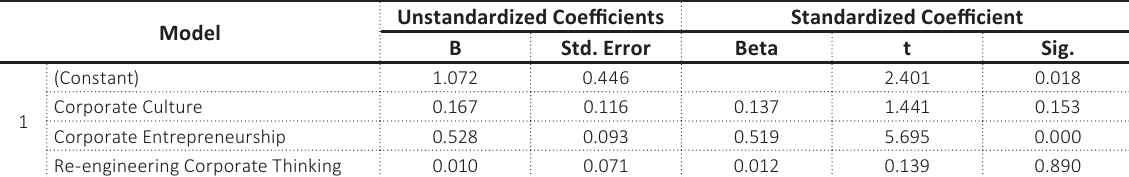
Table 15. Regressing intrapreneurship sub- variables on employee enhancement